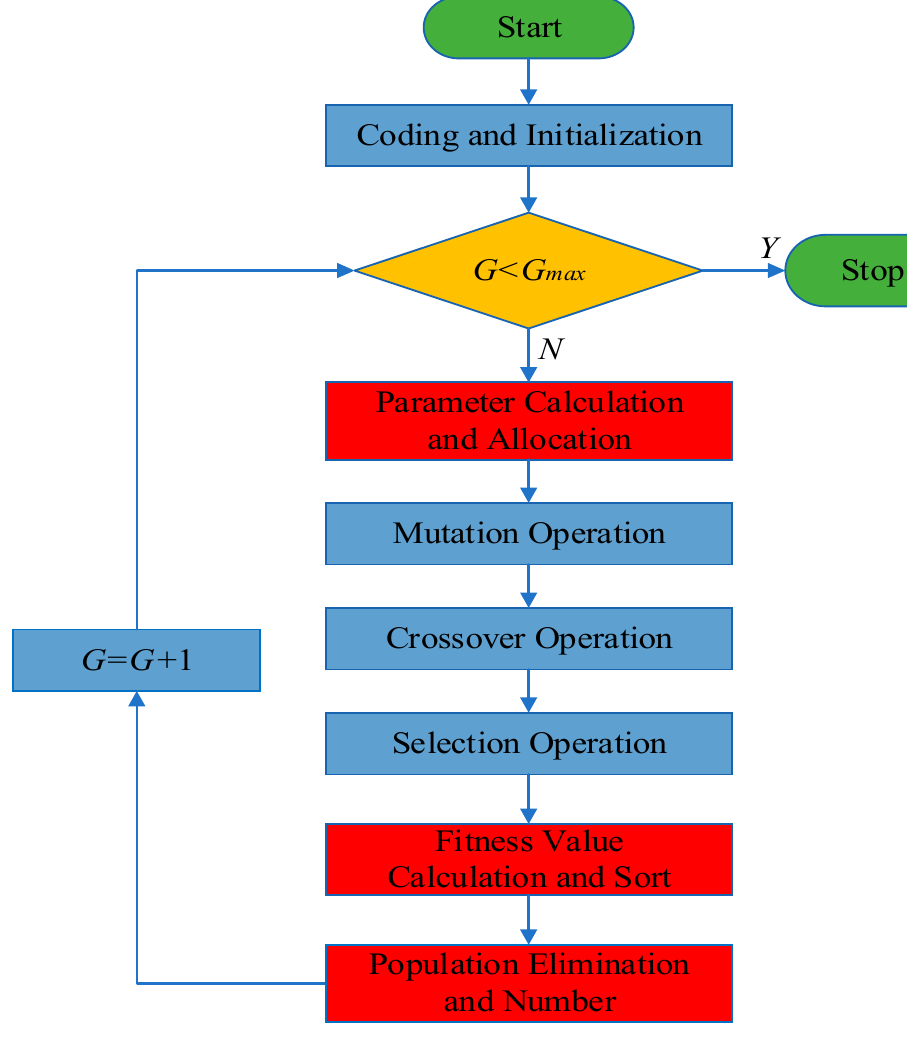
Figure 2. SAPRDE flow chart.